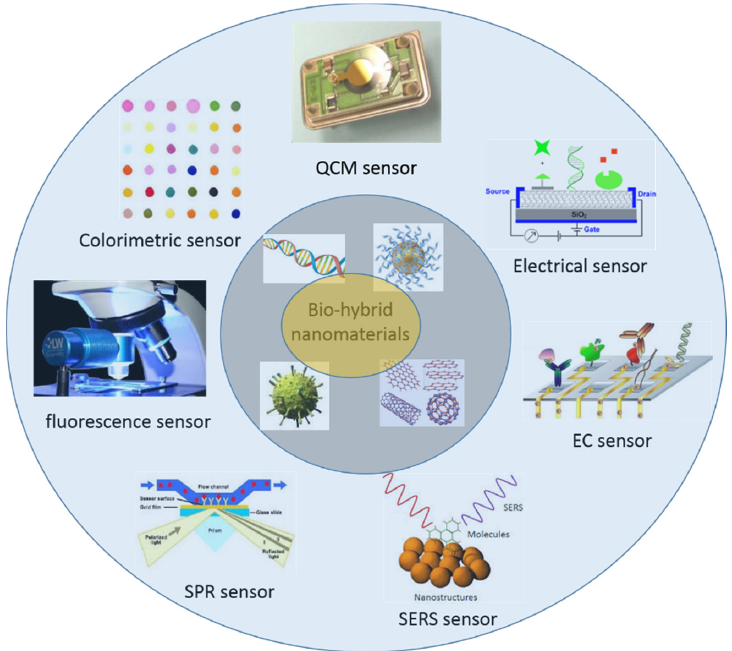
Figure 2. Potential sensor applications of the biomimetic hybrid nanomaterials.